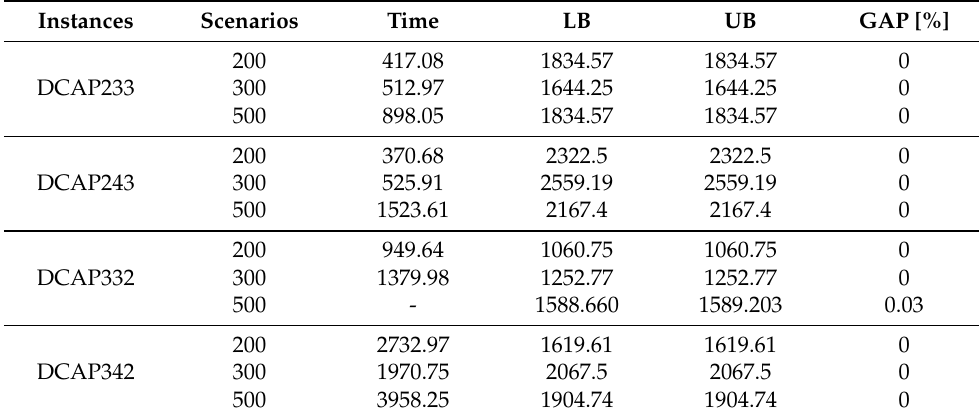
Table 5. Results of DSP with DW Branch-and- Bound on DCAP